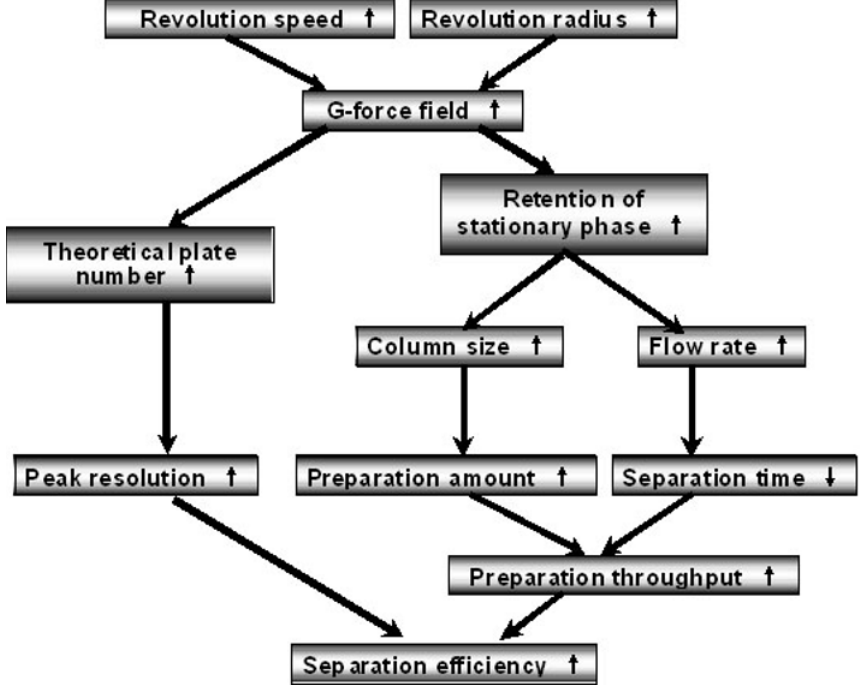
. Figure 2 Major relationships between instrumental parameters and performance of